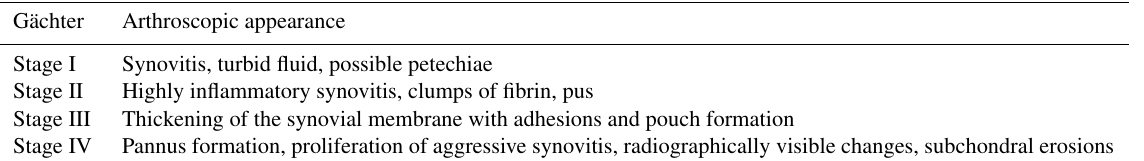
Table 1. Severity stages of SANJO based on the intraarticular appearance by either open or arthroscopic evaluation (Stutz et al., 2000). Gächter Arthroscopic appearance Stage I Synovitis, turbid fluid, possible petechiae Stage II Highly inflammatory synovitis, clumps of fibrin, pus Stage III Stage